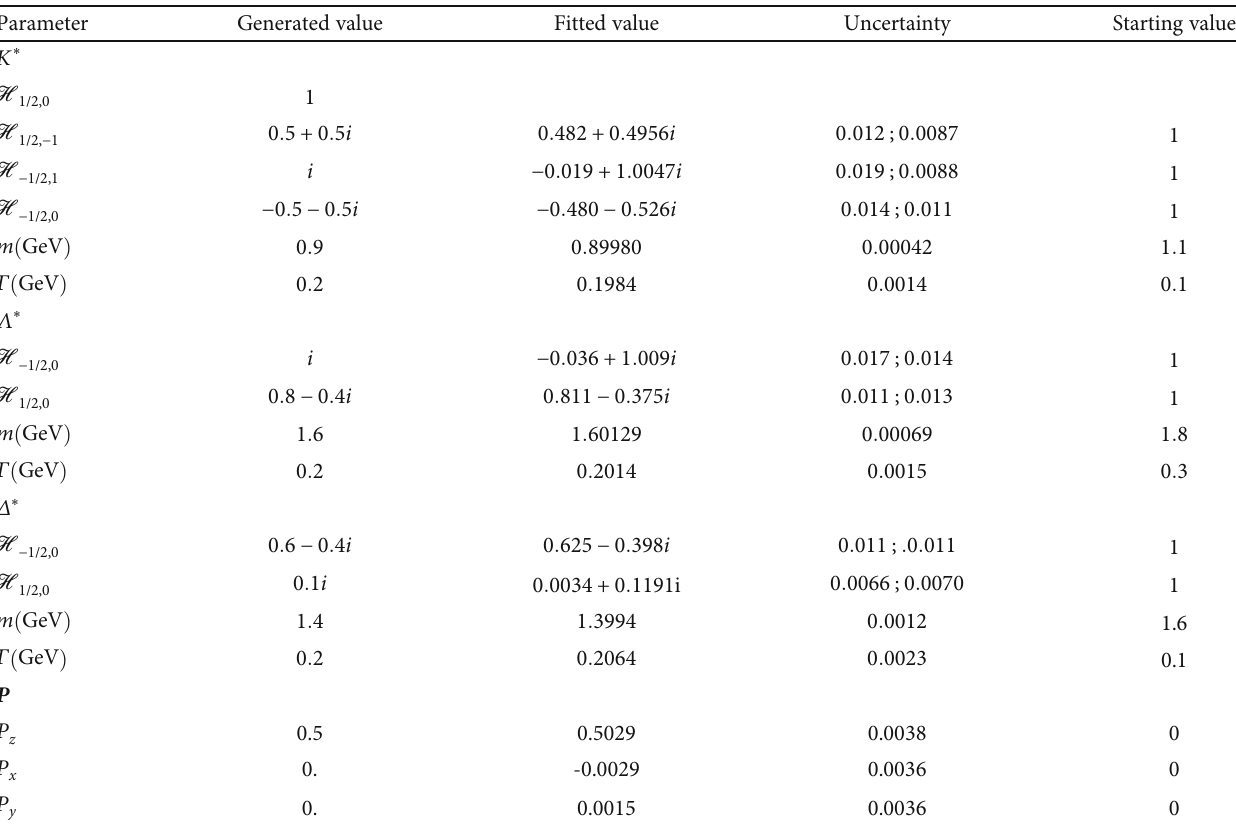
Table 2: Toy amplitude fi t study for nonzero polarisation ( P and imaginary part